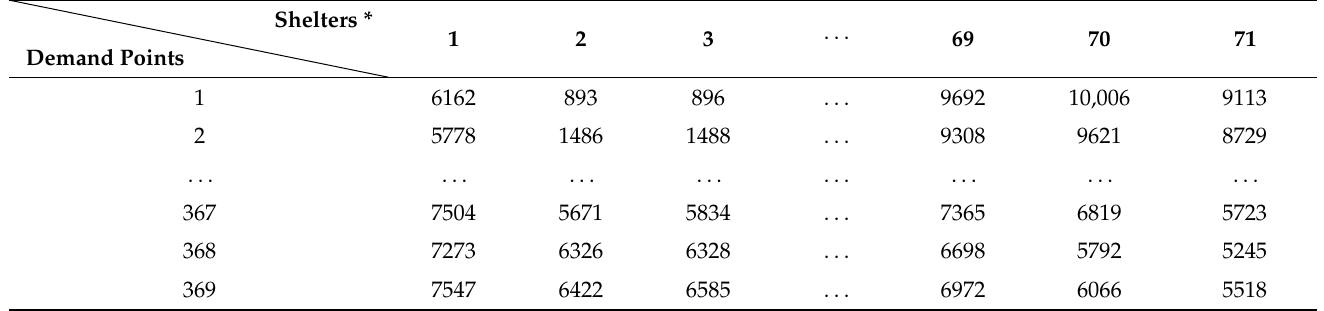
Figure 2. The spatial data of the central urban area of Xinyi City. Table 1. The OD matrix of the shortest distances from demand points to resident emergency congre- gate